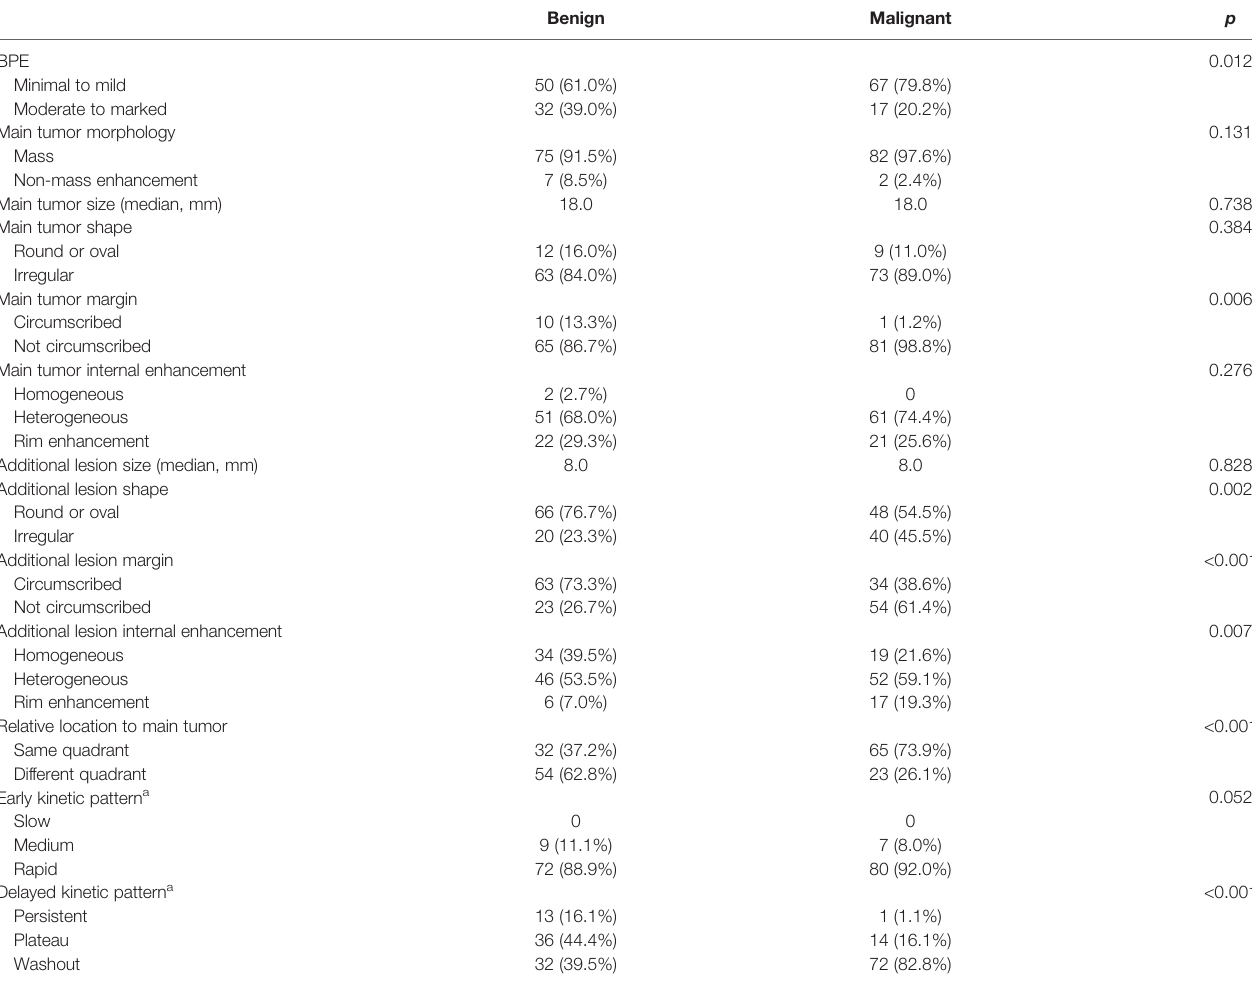
TABLE 1 | Comparison of preoperative clinical imaging interpretation features between benign and malignant groups.